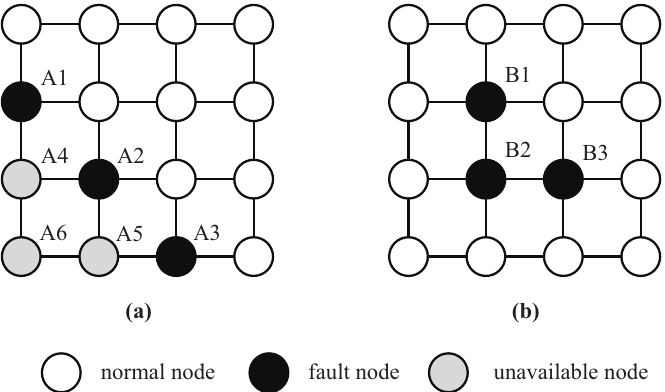
Figure 1. The effect of failure nodes on a network, ( a ) the failure nodes affect the communication between other nodes; ( b ) the failure nodes do not affect the communication between other nodes.